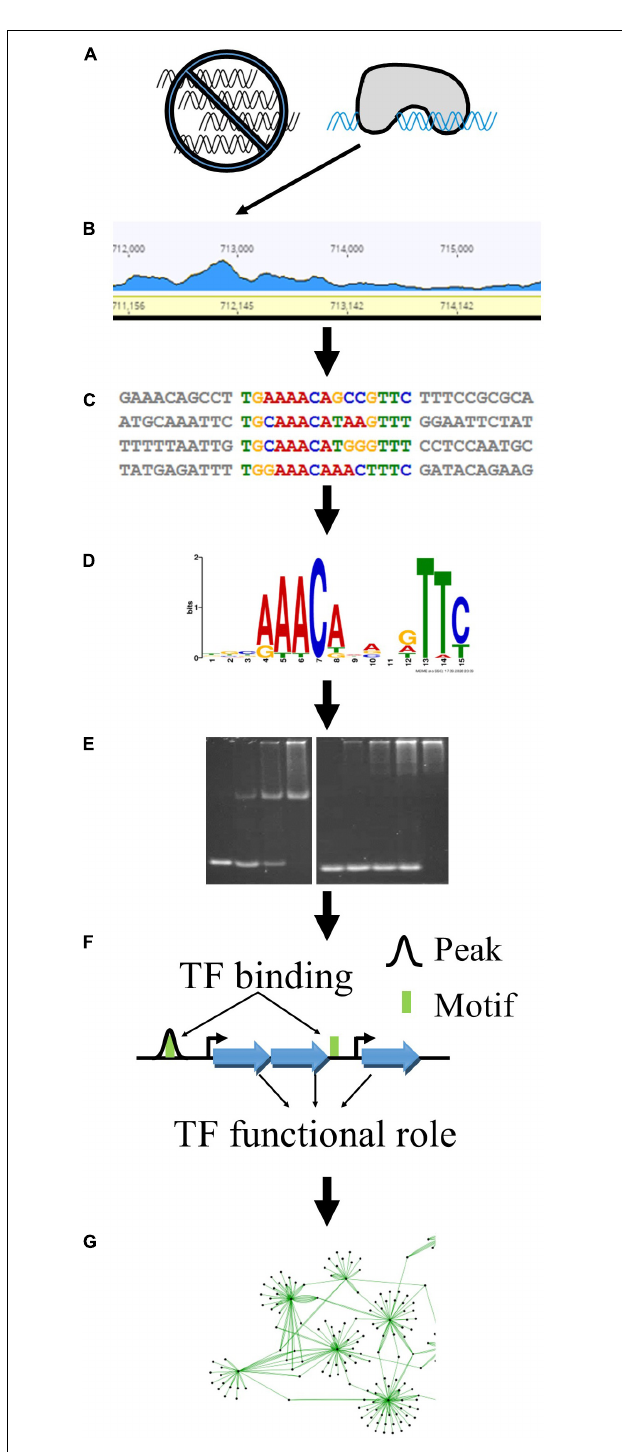
FIGURE 1 | Experimental and bioinformatic approach to determine TF regulatory networks. This approach begins with large-scale analysis of putative TFs by DAP-seq. TF-bound DNA fragments are purified away from a genomic DNA library (A) and identified as local peaks in the mapped sequencing read landscape (B) . The sequences underlying these peaks (C) are further analyzed to find enriched DNA sequence motifs (D) . We validate